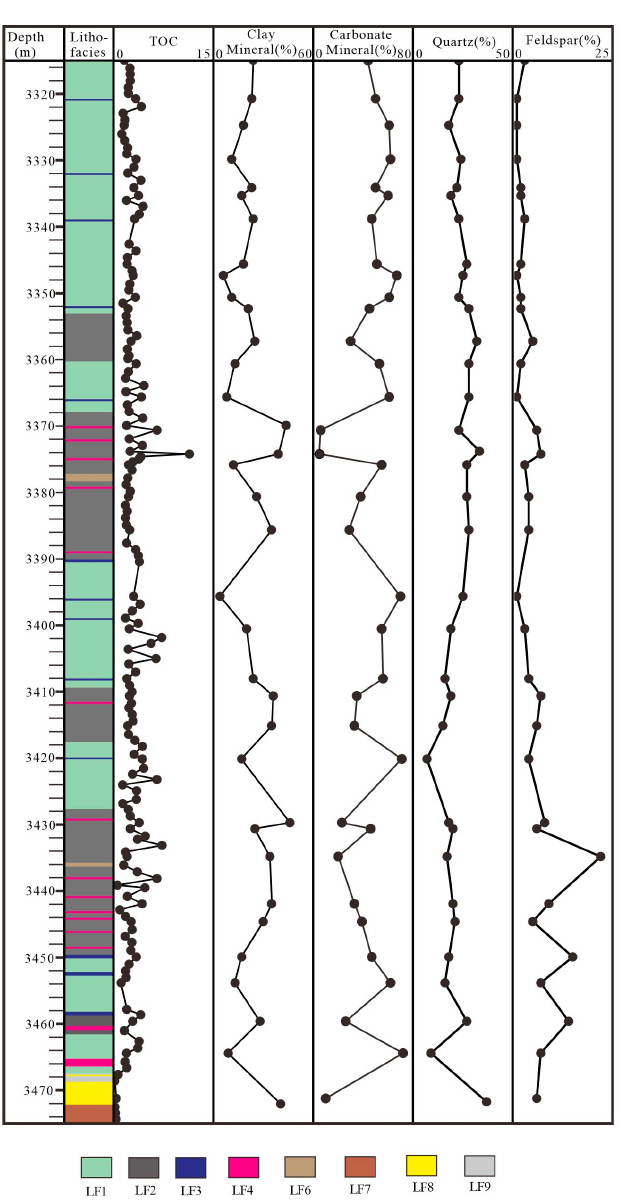
Figure 10. The main mineral composition in different lithofacies of the Es4s shale in well NY1.